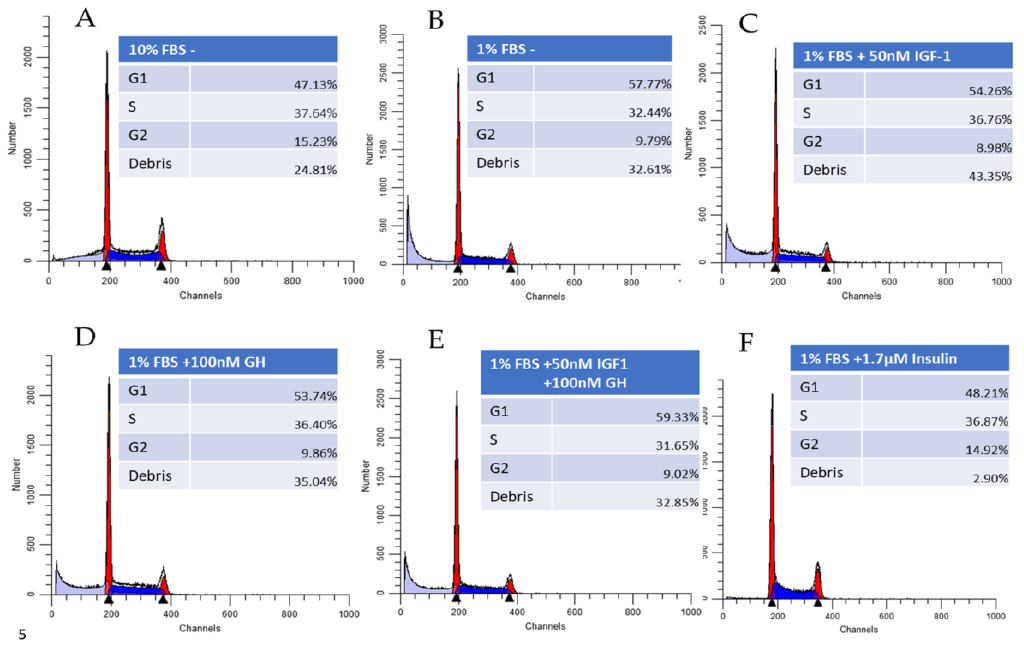
Figure A1. In vitro tumor growth of the Ewing sarcoma cell line with various growth factors. Flow cytometry results for the SKNMC cell line after 72-h incubation in different conditions. ( A ) Cells cultured in standard 10% Fetal bovine serum (FBS) medium. ( B ) Cells cultured in 1% FBS medium. ( C ) Cells cultured in 1% FBS medium with 50-nM IGF1. ( D ) Cells cultured in 1% FBS medium with 100-nM GH. ( E ) Cells cultured in 1% FBS medium with 50-nM IGF1 and 100-nM GH. ( F ) Cells cultured